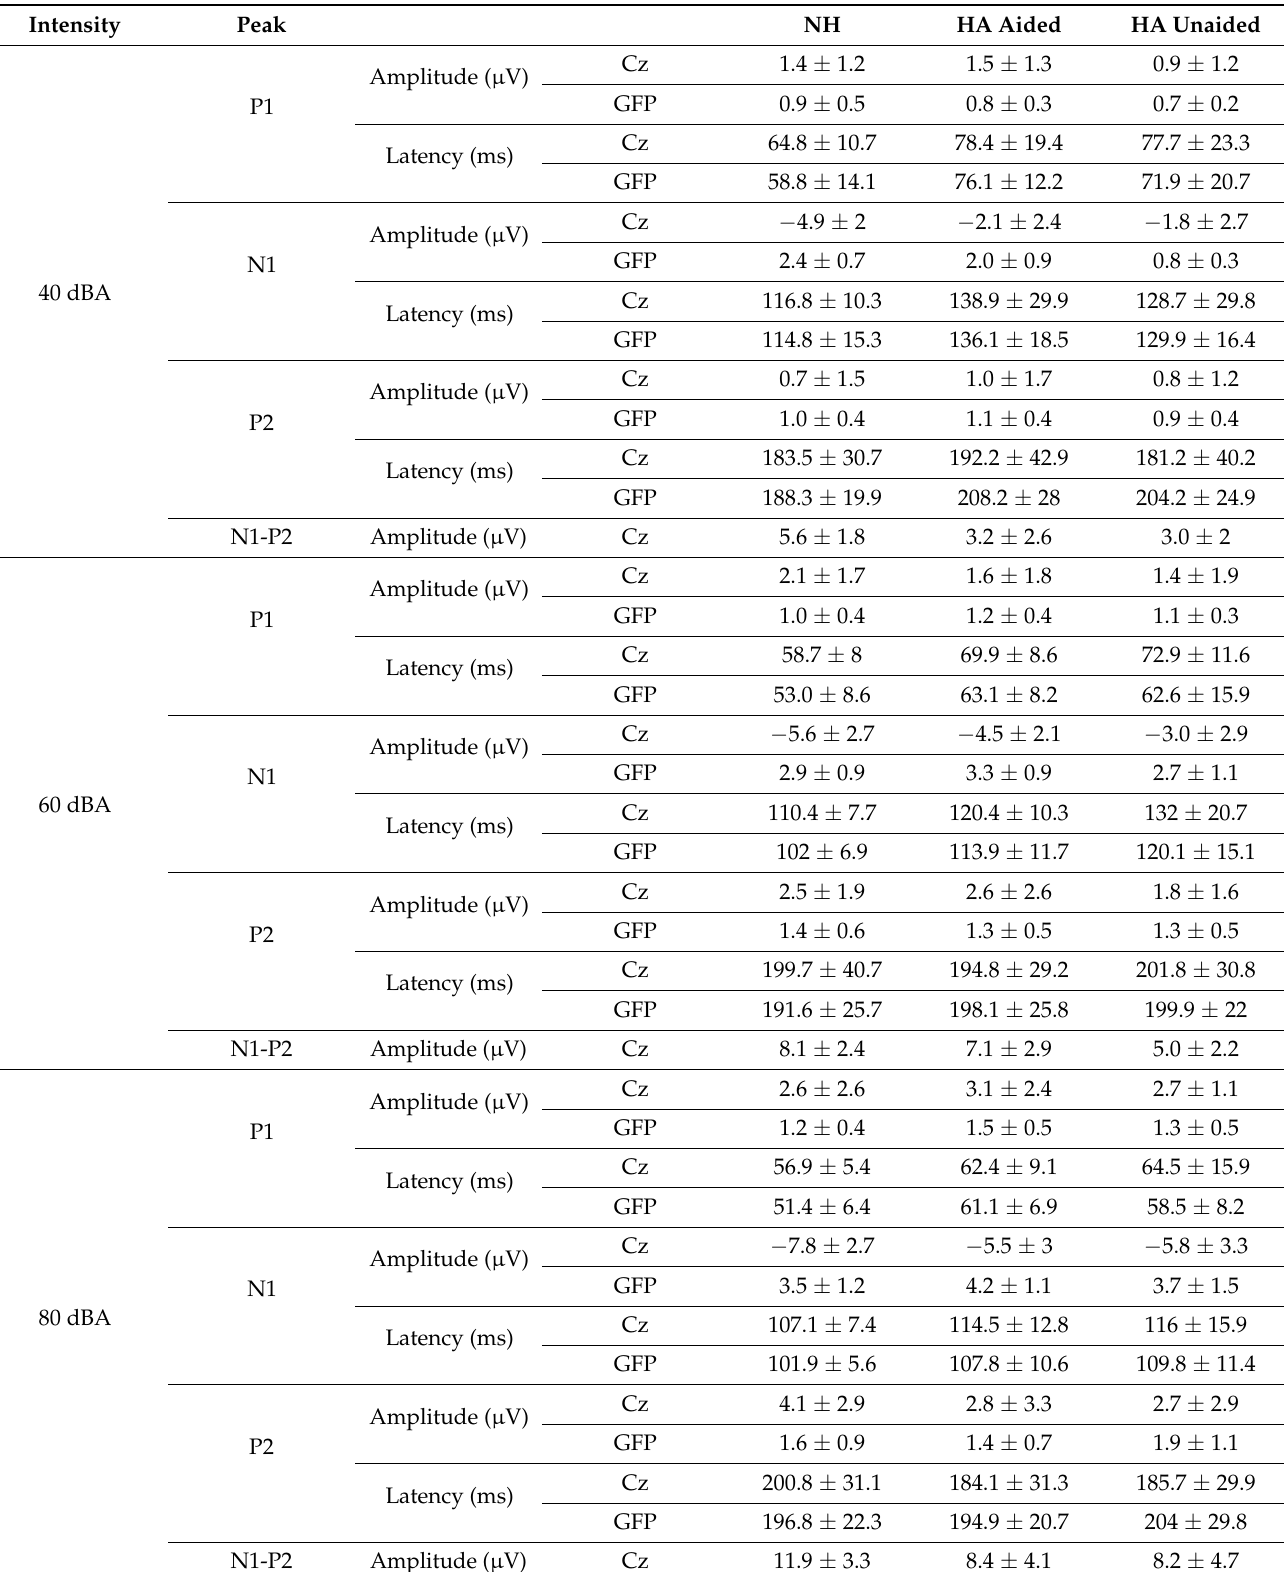
GFP = global field power; NH = normal hearing; HA = hearing